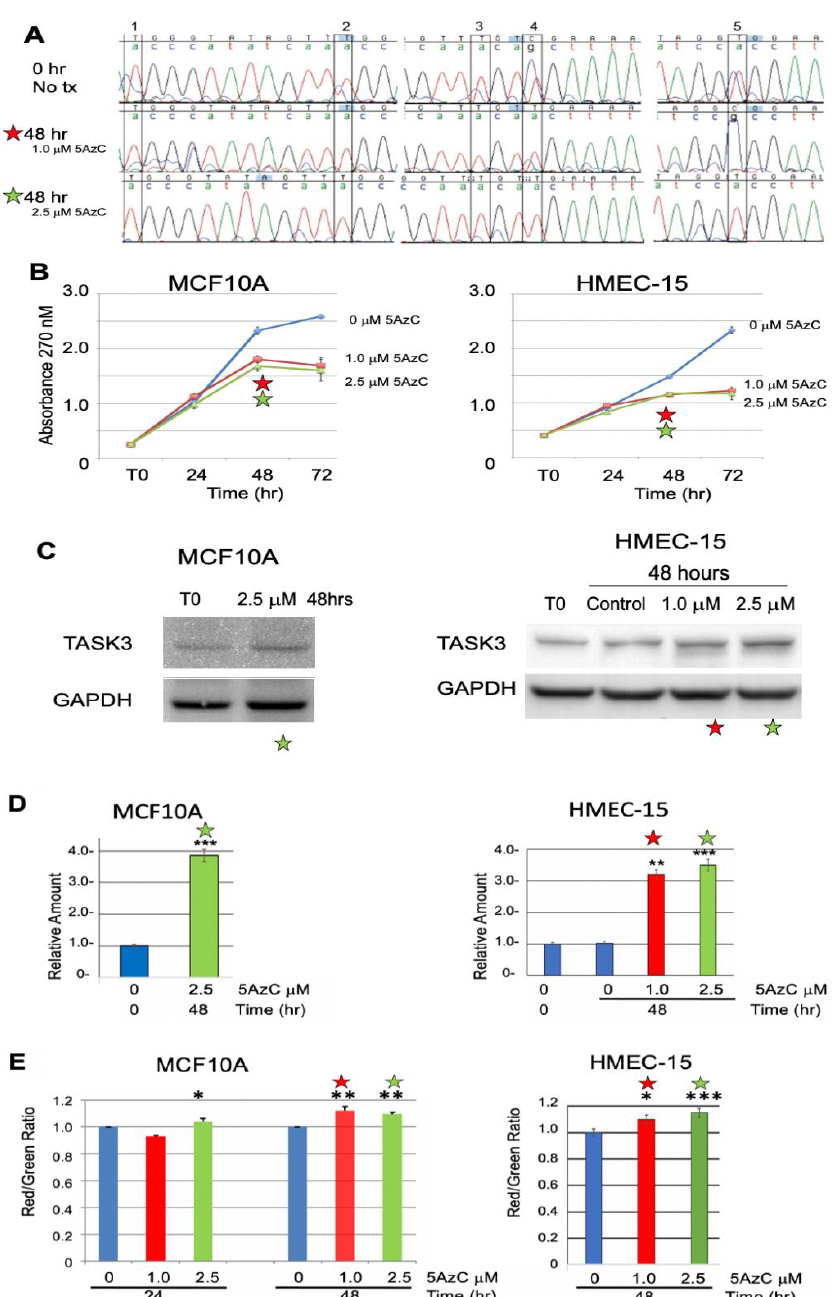
Figure 4. TASK3 expression and mitochondrial membrane potential as a function of KCNK9 -US1 DMR demethylation in MCF10A cells and HMEC-15 normal cell strain. The optimal treatment conditions are 48 h for either 1.0 (red star) or 2.5 µ M (green star) 5-aza-2′-deoxycytidine (5AzC) ( A ) Effect of 1.0 and 2.5 µ M 5AzC on the DNA methylation of CpG sites 1–5 (boxes) in the KCNK9 -US1 DMR in MCF10A. ( B ) Cell proliferation (viability) was tested using the MTT assay at 0–72 h; MCF10A cells and HMEC-15 normal cell strain were treated with 0 (blue line), 1.0 (red line), and 2.5 µ M (green line) 5-AzC. Experiments were performed in triplicate. ( C ) Expression of ASK3 protein analyzed by western blotting at 0 and 48 h in MCF10A after treatment with 2.5 µ M 5AzC and HMEC-15 normal cell strain after treatment with 1.0 and 2.5 µ M 5AzC. GAPDH is used as the loading control. ( D ) Relative TASK3 expression in MCF10A after treatment with 2.5 µ M 5AzC for 0 and 48 h and HMEC-15 normal breast cell strain after treatment with 1.0 and 2.5 µ M 5AzC for 0 and 48 h. TASK3 expression was normalized to 0 h treatment (Control). Expression is for the western blots